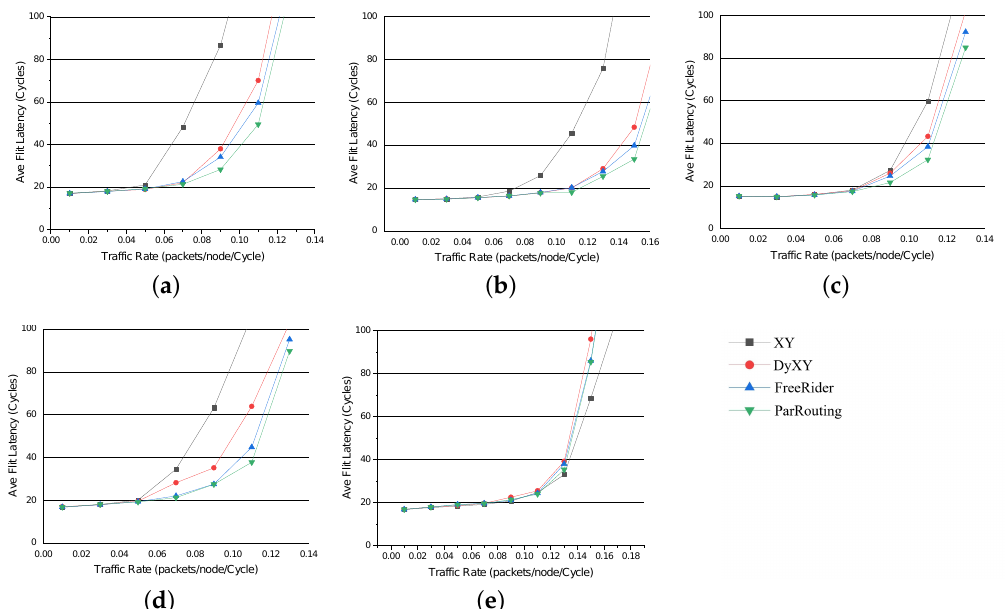
Figure 11. Performance on an 8 × 8 2D Mesh network for synthetic traffic pattern. ( a ) bit_reverse. ( b ) bit_rotation. ( c ) shuffle. ( d ) transpose. ( e )